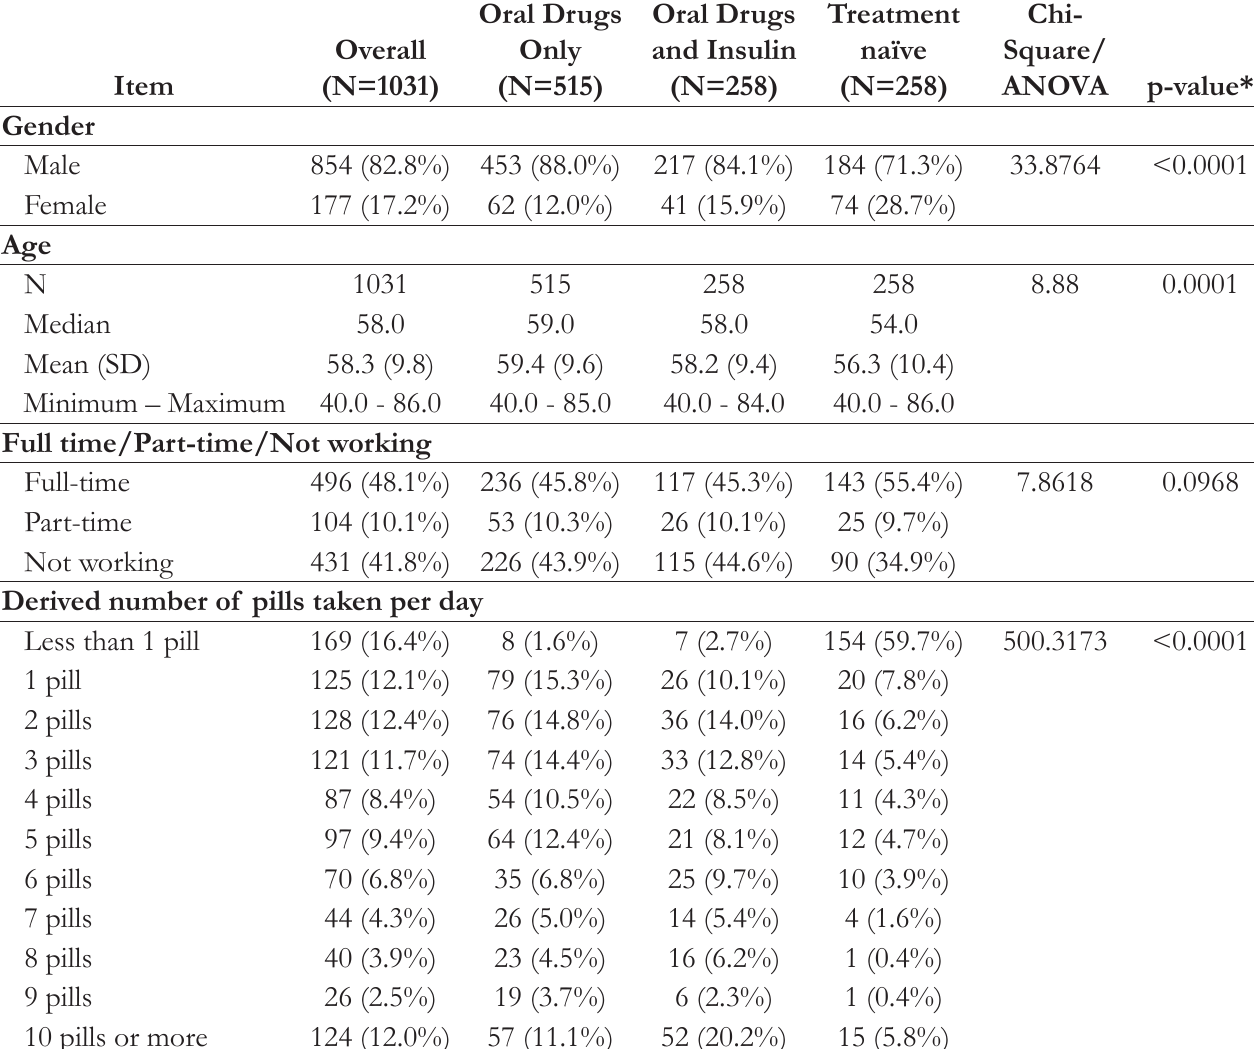
Table 2. Overall and Group Demographic Characteristics of T2DM Patients